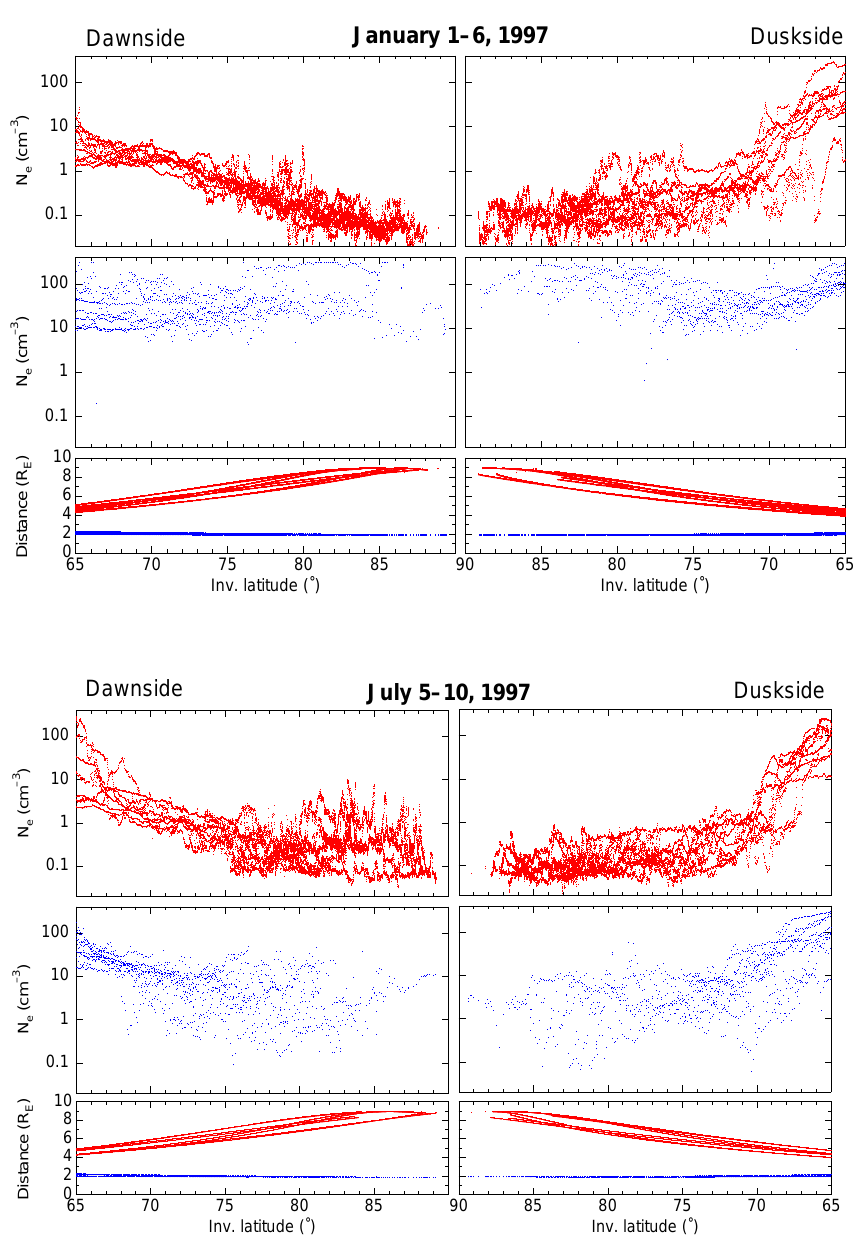
Fig. 4. Same as Fig. 3 but for the inter- val 5–10 July 1997. Contrary to Fig. 3, here the northern polar ionosphere is il- luminated by the Sun and the southern polar ionosphere is in